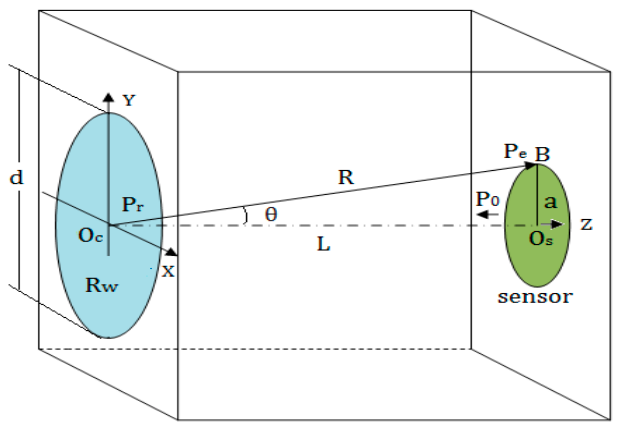
Figure 5. The model for calculating the echo sound pressure by using the Kirchhoff approximation theory.